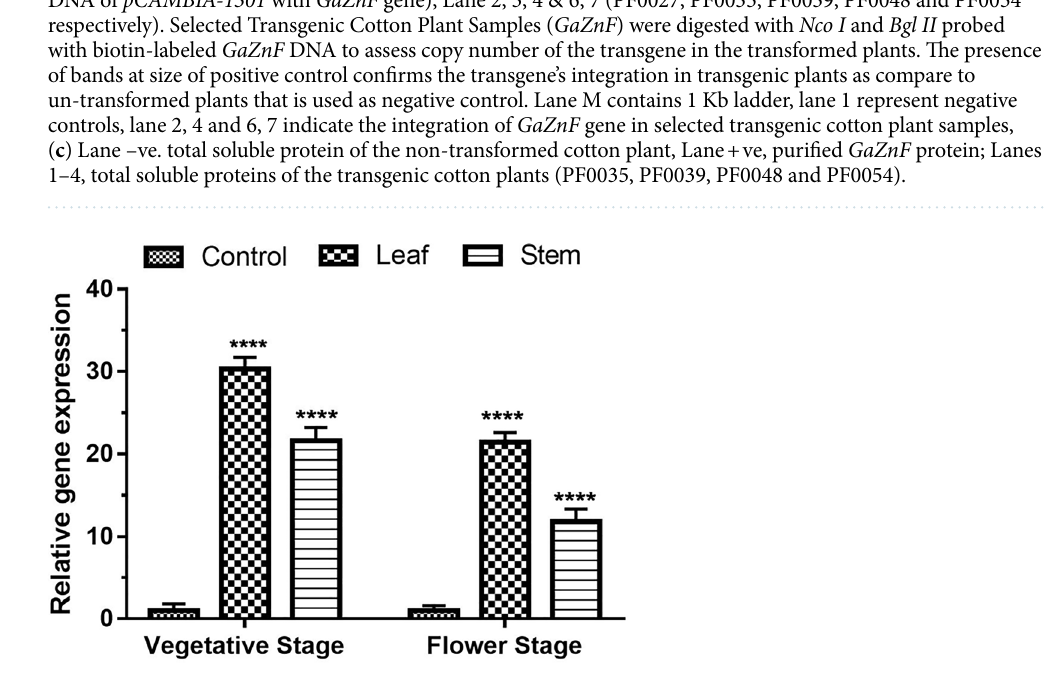
in PF0027, PF0039 and PF0054 at day 10 of drought stress as compared to non-transgenic control plant that is 215 µmolm −2 s −1 (Fig. 8e). Two-way ANOVA indicated the significant difference between the relative leaf water content, chlorophyll, photosynthesis, transpiration rate and stomatal conductance of transgenic and non- transgenic genotypes ( P < 0.05). In counter drought stress conditions, proline values triggered for the defense of plants are more in the transgenic plant than non-transgenic control plants. Proline values at day 5 of drought stress is 7.1µggm −1 , 9.02 µggm −1 and 14.3 µggm −1 in PF0027, PF0039 and PF0054, respectively, as compared to non-transgenic control plant that is 4.5 µggm −1 while at day 10 the values were 11.5 µggm −1 , 14.9 µggm −1 and 18.3 µggm −1 in PF0027, PF0039 and PF0054 respectively as compared to non-transgenic control plant that is 6.3 µggm −1 (Fig. 8f). Soluble sugars also increased in response to drought stress in transgenic lines as 10 mggm −1 , 11.4 mggm −1 and 11.9 mggm −1 in PF0027, PF0039 and PF0054 as compare to non-transgenic control plant that